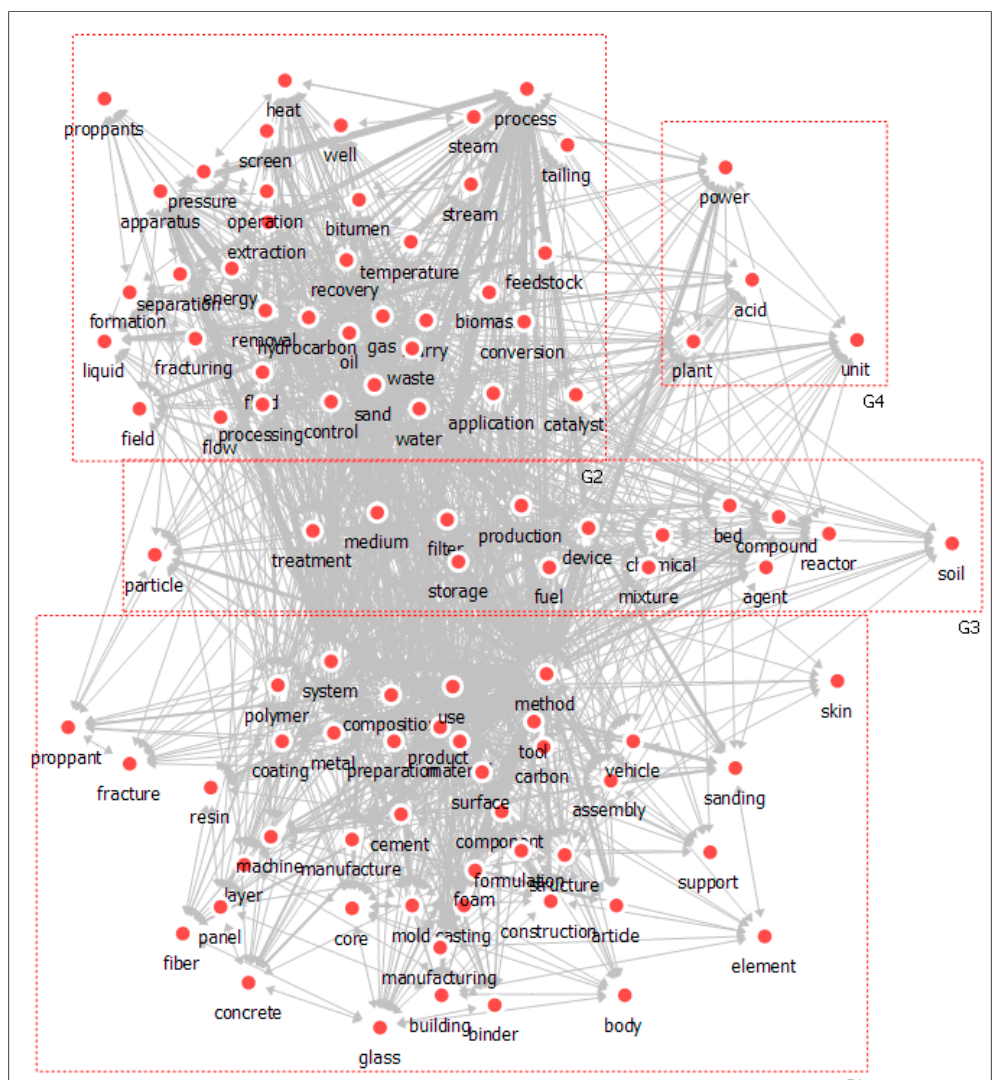
Figure 2. Group network analysis of digital oil fields .